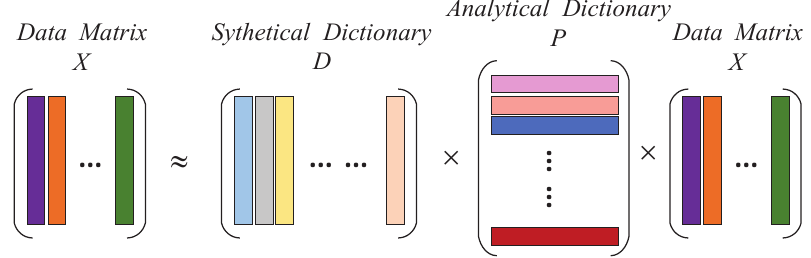
) Figure 3. Structure diagram of dictionary pair learning.